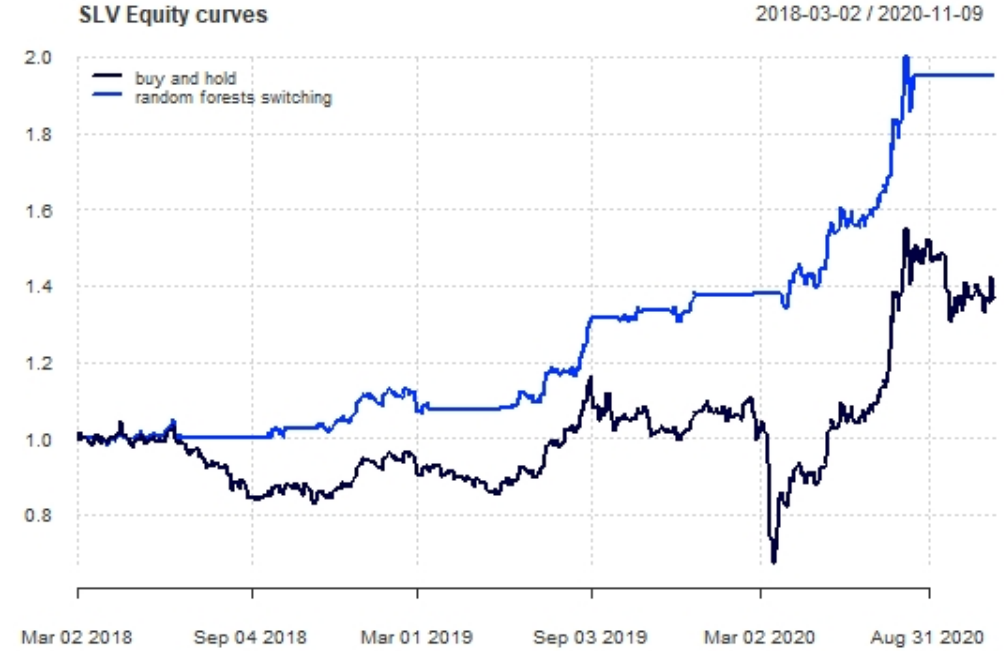
Figure 13. This figure shows SLV equity curves comparing the buy and hold portfolio with the random forests switch- ing